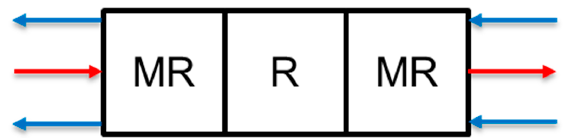
Figure 12. Proposed redesign of the polymer membrane reactor with membrane being removed from the center of the unit (MR = polymer membrane reactor, R = Reactor).